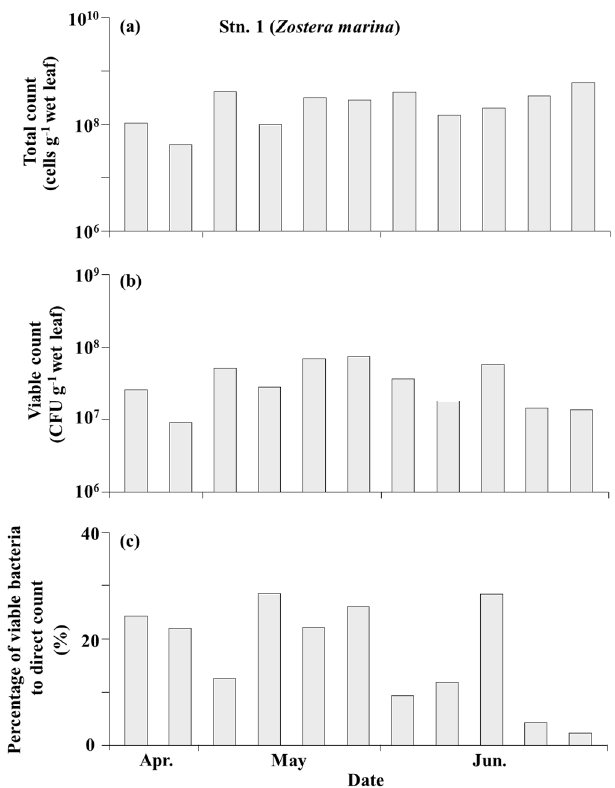
Figure 5. Bacterial numbers in the eelgrass Zostera marina samples from Stn. 1: the direct counts ( a ), the viable counts (CFU) ( b ), and the percentages of viable counts to direct counts ( c ).